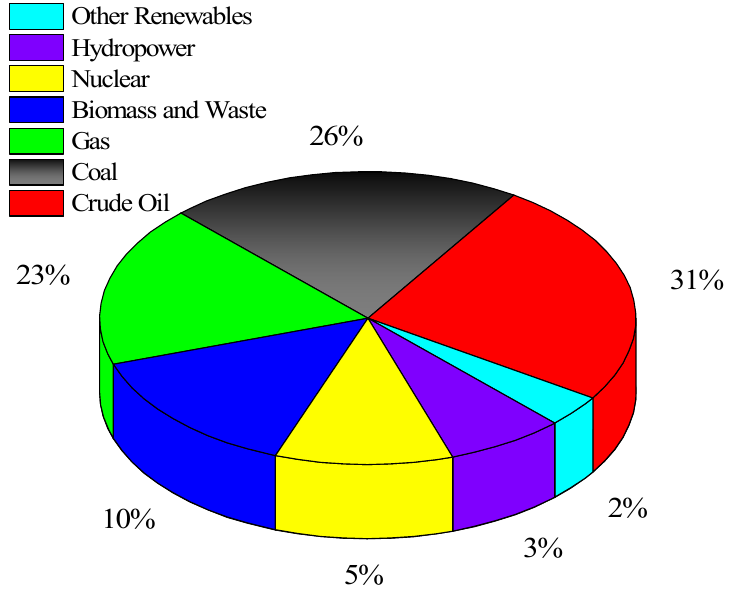
Figure 2. Major contributors to global energy demand [89].